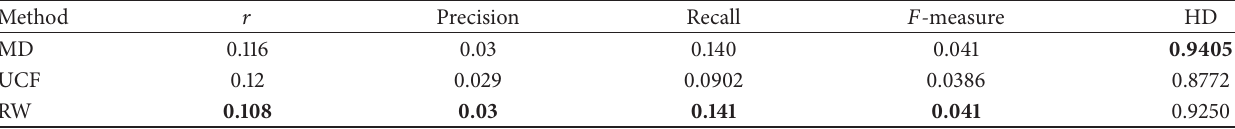
Table 3: Algorithmic performance for Friendfeed data set with recommendation list 𝐿 = 20